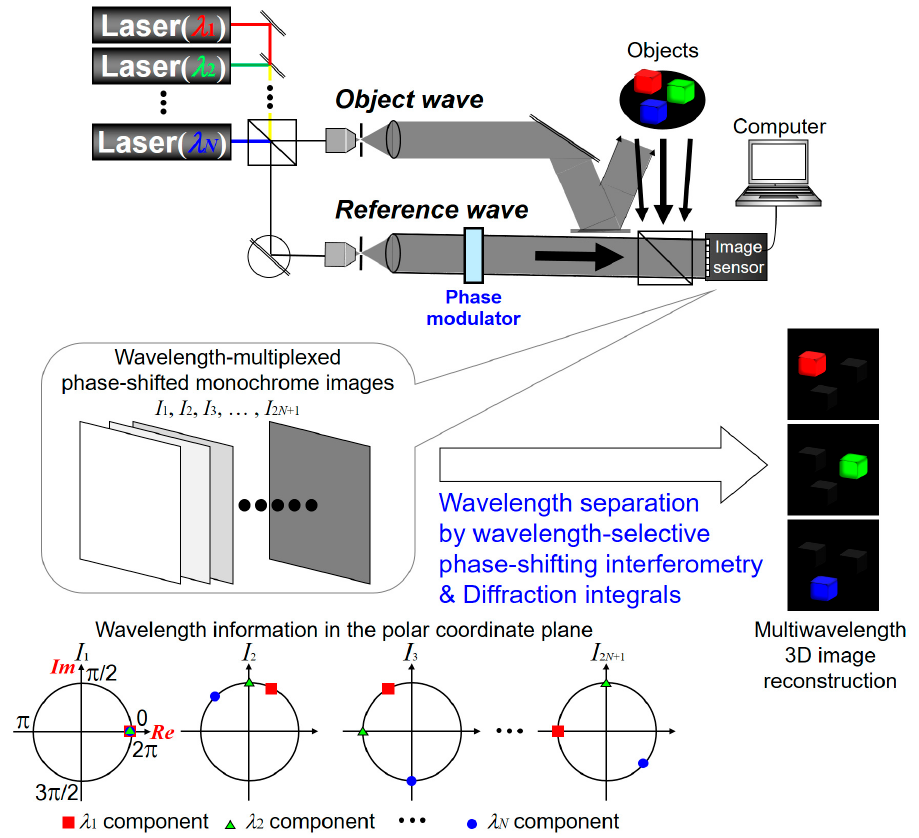
Figure 1. Schematic of wavelength-selective phase-shifting DH (WSPS-DH).